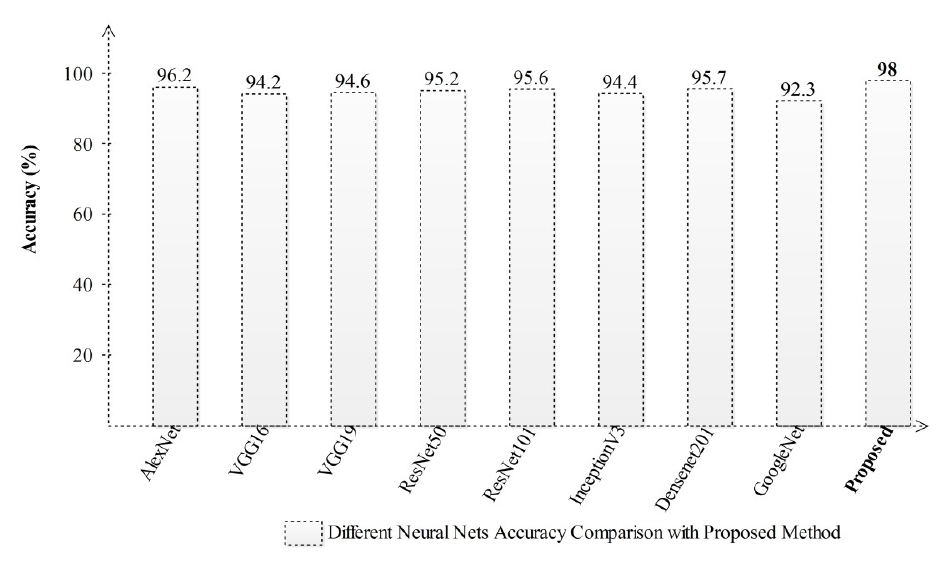
Figure 11. Comparison of the accuracy achieved with different deep learning models.